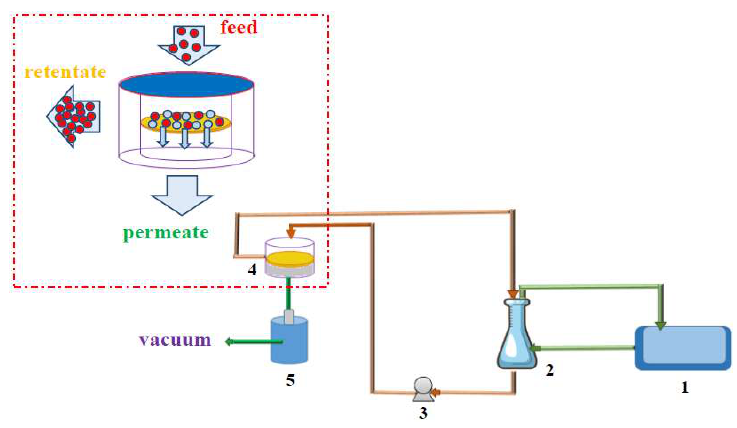
Figure 2 . Pervaporation rig used during vacuum pervaporation experiments: ( 1 ) thermostat, ( 2 ) thermostated feed tank, ( 3 ) circulating pump, ( 4 ) membrane module, ( 5 ) permeate cold trap.